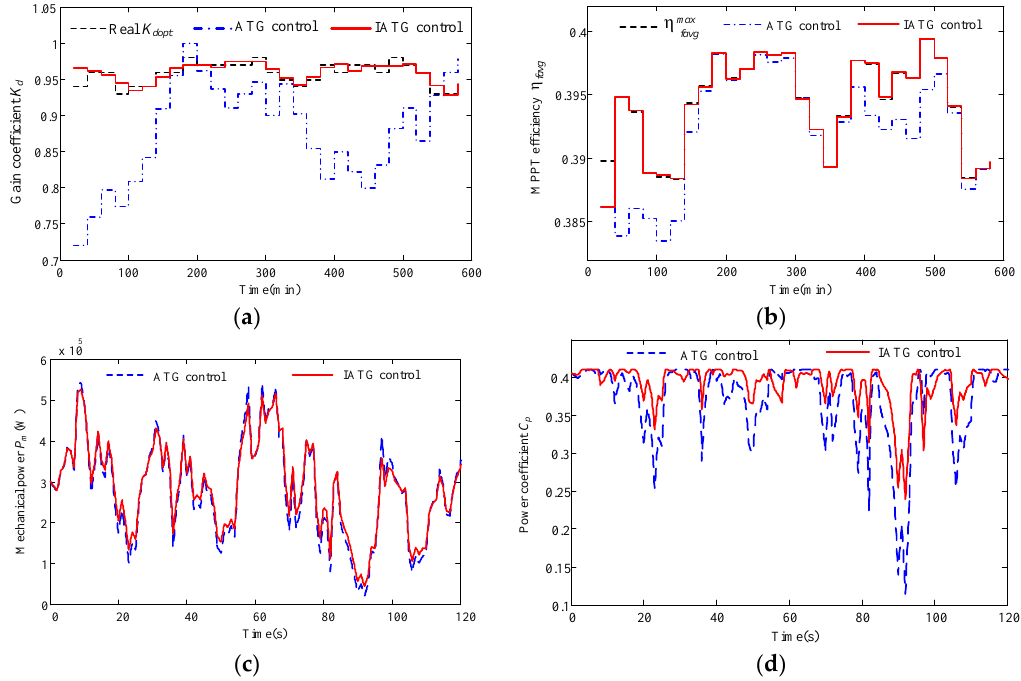
Figure 13. MPPT performances in searching the optimal gains under wind speed with T i of category C: ( a ) K d of ATG and IATG control; ( b ) MPPT efficiency η favg ; ( c ) mechanical power P m ; and ( d ) power coefficient C p .